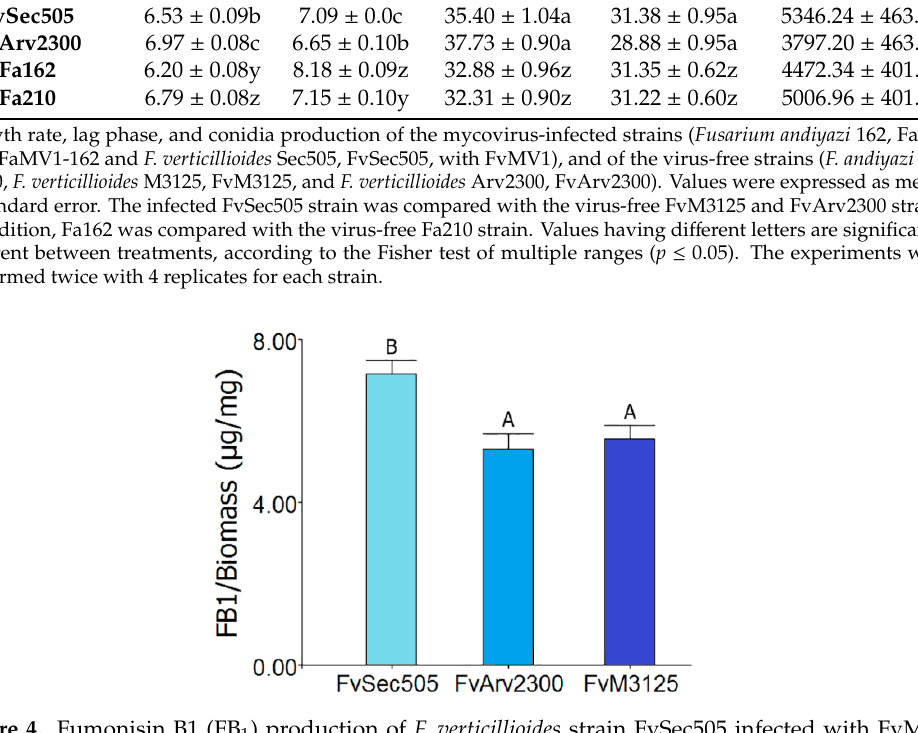
Figure 4. Fumonisin B1 (FB 1 ) production of F. verticillioides strain FvSec505 infected with FvMV1